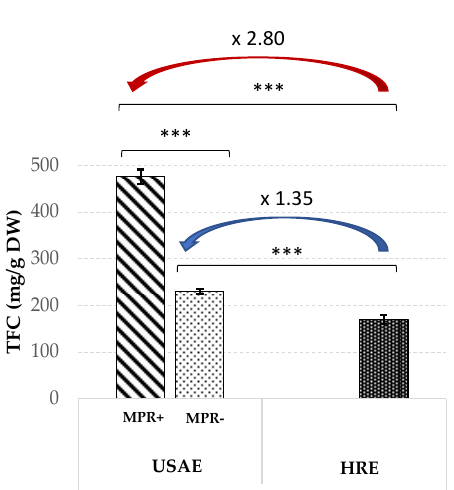
Figure 4. Comparison of TFC extracted from N. lotus stamens using traditional HRE and presently optimized UAE alone (MPR − ) or coupled with the optimized DAX-8 macroporous resin purification step (MPR+). Values are means ± SD of three independent experiments. *** significant p < 0.001.